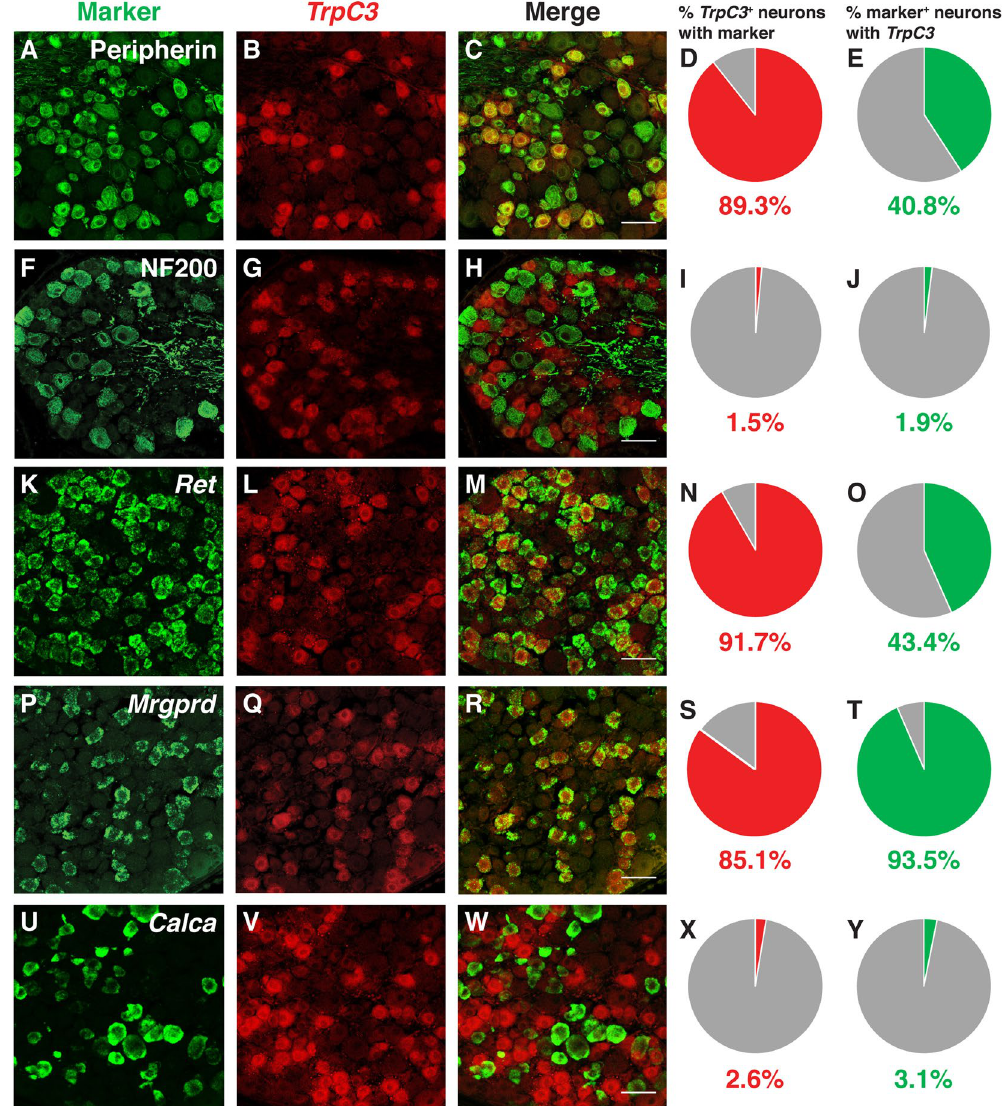
Figure 2. Characterization of TrpC3 expression in DRG neurons. ( A – J ) Fluorescent in situ hybridization for TrpC3 and immunostaining using antibodies against peripherin ( A–E ) and NF200 ( F – J ), along with percentage overlap quantification, in P21 WT mouse DRG thoracic sections. ( K–Y ) Double fluorescent in situ hybridization for TrpC3 and Ret ( K–O ), Mrgprd ( P–T ), and Calca ( U–Y ), along with percentage overlap quantification, in P21 WT mouse DRG thoracic sections. TrpC3 overlaps with the small diameter DRG neuron marker peripherin and the non-peptidergic neuron markers Ret and Mrgprd , but shows minimal overlap with the large diameter DRG neuron marker NF200 and the peptidergic neuron marker Calca . N = 3 mice, Scale bar = 50 μ